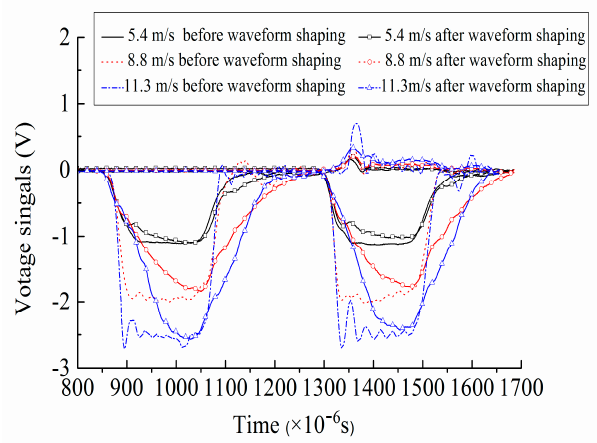
Figure 4. Waveform shaping images under different loading speeds.